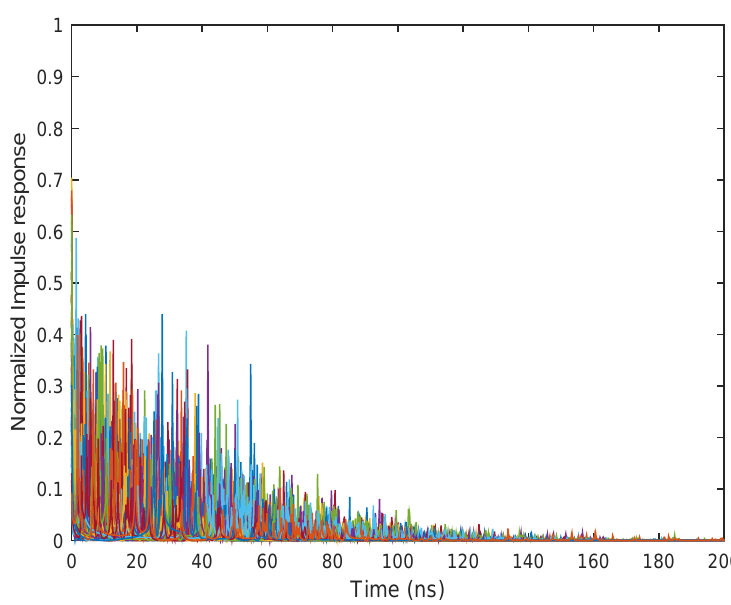
Figure 7. Normalized impulse response of the IEEE 802.15.4a CM1 channel model for the indoor residential line of sight